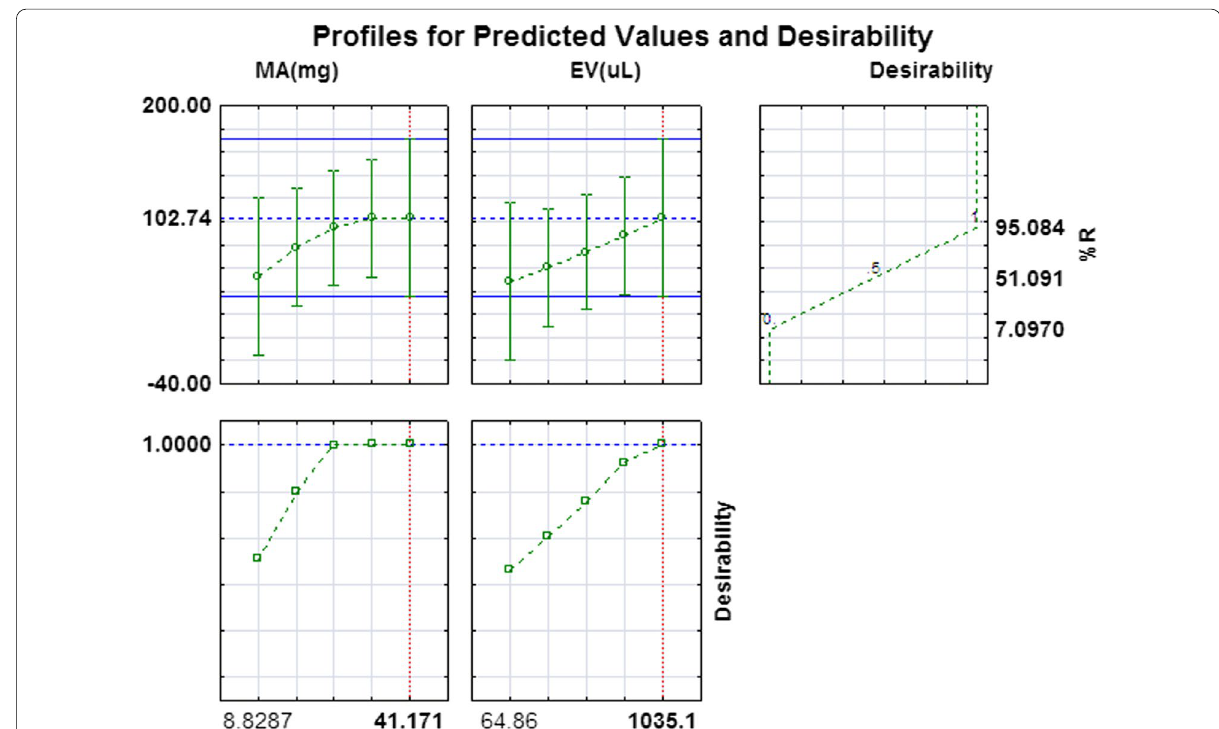
Fig. 8 Desirability profile indicating the predicted values and desirability functions for neonicotinoids (TCL). MA mass of adsorbent, EV eluent volume